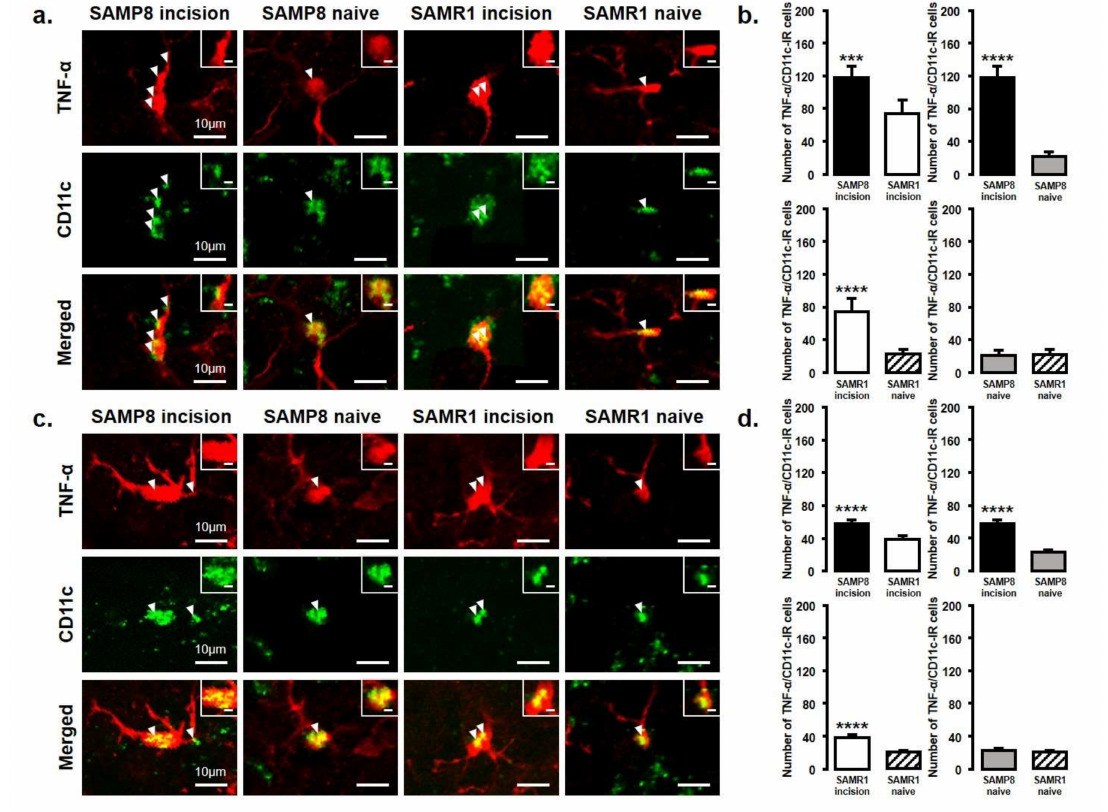
Figure 5. TNF- α released from M1 phenotype microglia in the Vc and C1 / C2 regions on day 3 and day 11 after palatal mucosal incision. ( a ) Low and high (inset) magnification photomicrographs of TNF- α -IR cells (red), CD11c-IR cells (green), and TNF- α -IR / CD11c-IR cells in the Vc and C1 / C2 regions on day 3 after palatal mucosal incision in SAMP8 and SAMR1 mice. The arrowheads indicate TNF- α -IR / CD11c-IR cells. Scale bar: 10 µ m. Scale bar in the inset: 3 µ m. ( b ) The number of TNF- α -IR / CD11c-IR cells in the medulla on day 3 after palatal mucosal incision in SAMP8 and SAMR1 mice. Data represent mean ± SD ( n = 5 for SAMP8 incision mice, SAMR1 incision mice, and SAMR1 naive mice. n = 4 for SAMP8 naive mice; *** p < 0.001, **** p < 0.0001, Student’s t -test). ( c ) Low and high (inset) magnification photomicrographs of TNF- α -IR cells (red), CD11c-IR cells (green), and TNF- α -IR / CD11c-IR cells in